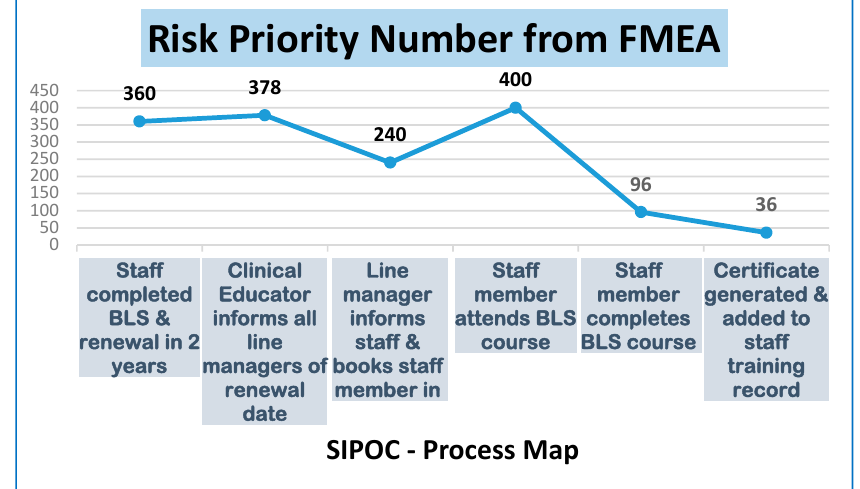
Figure 3. Risk Priority Number Report.